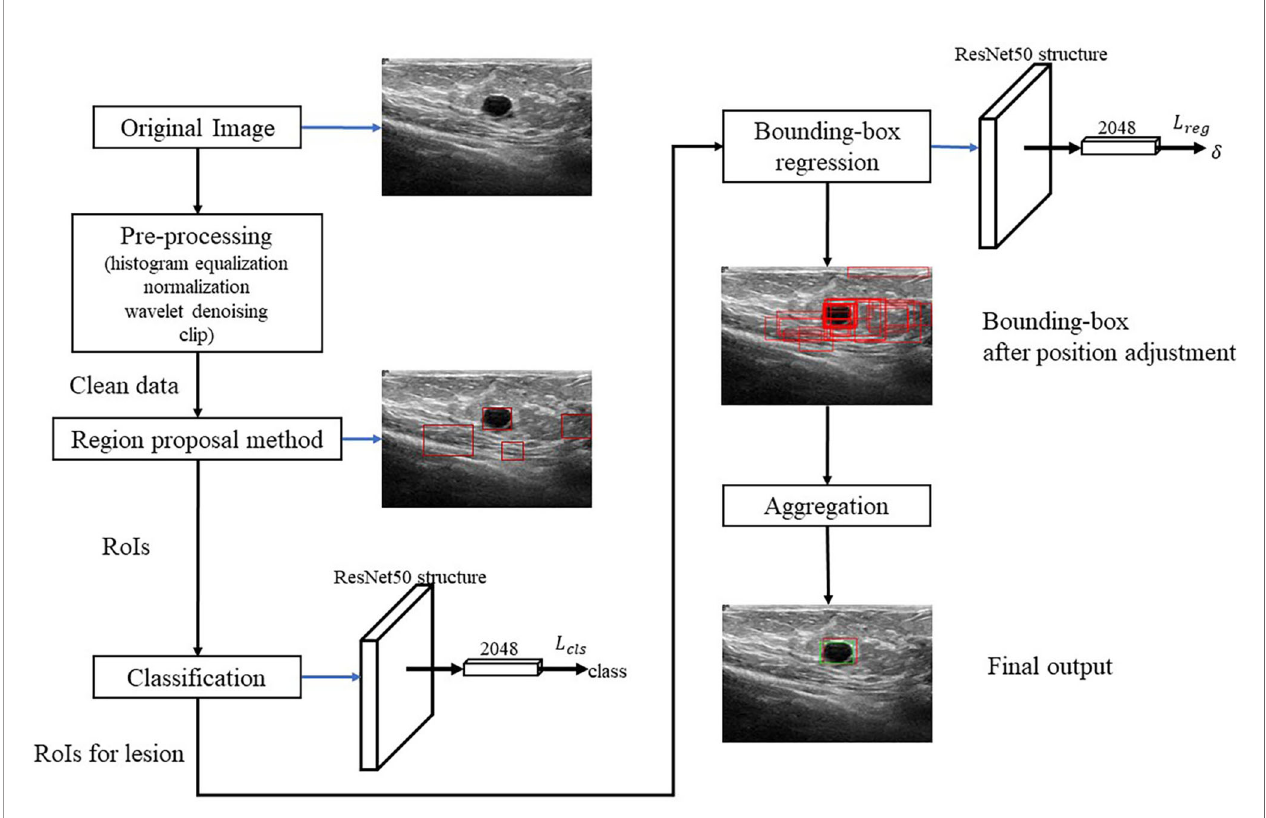
FIGURE 2 | Framework of